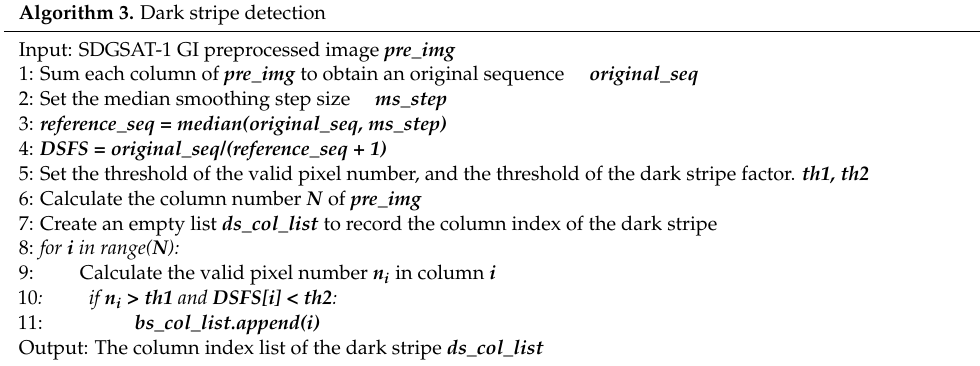
Algorithm 3. Dark stripe